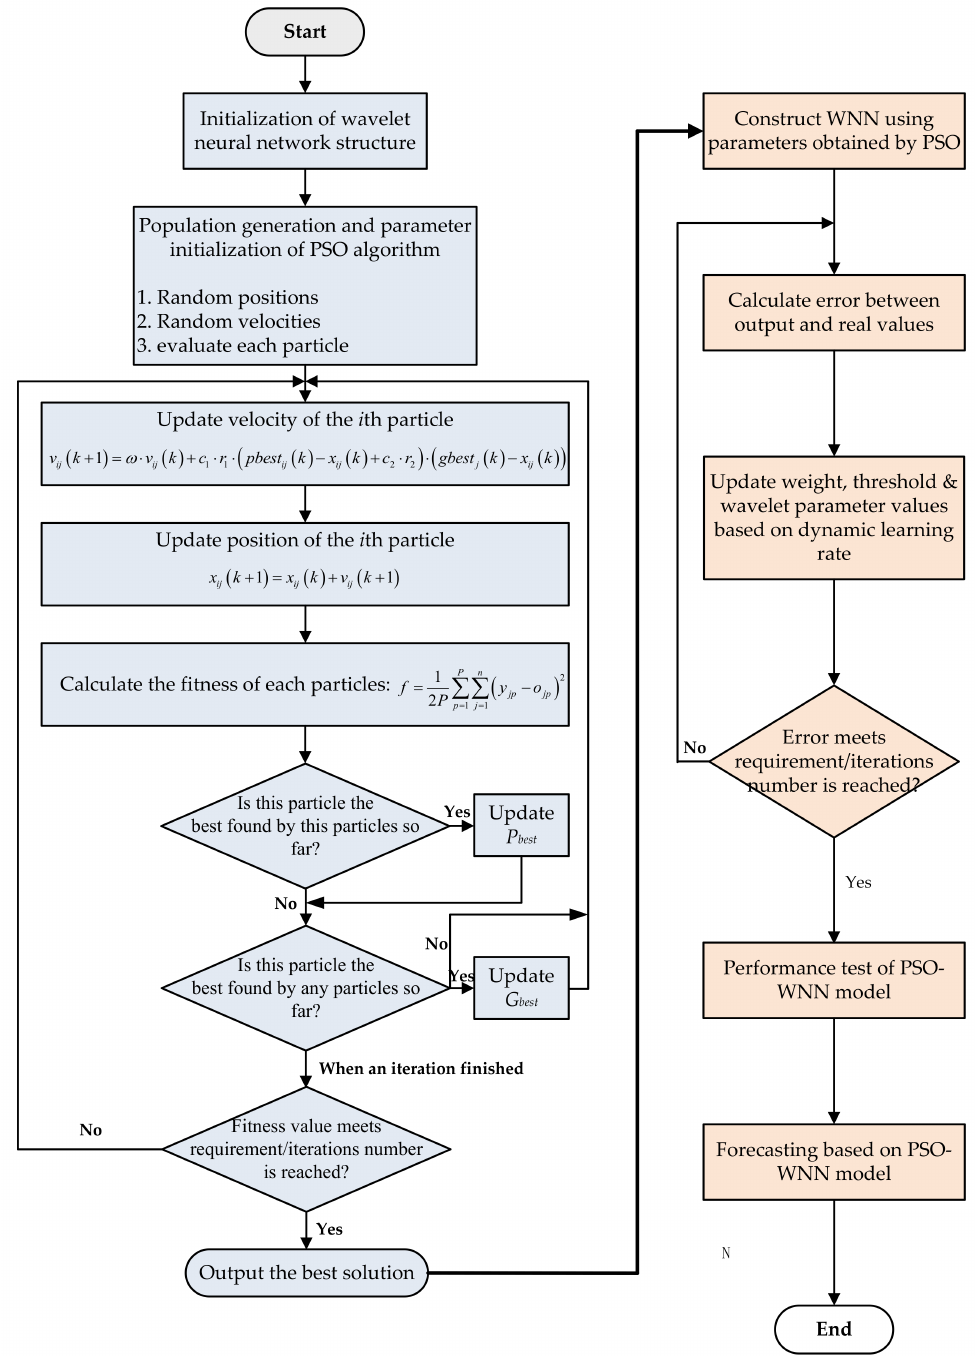
Figure 2. Flowchart of hybrid PSO-WNN forecasting